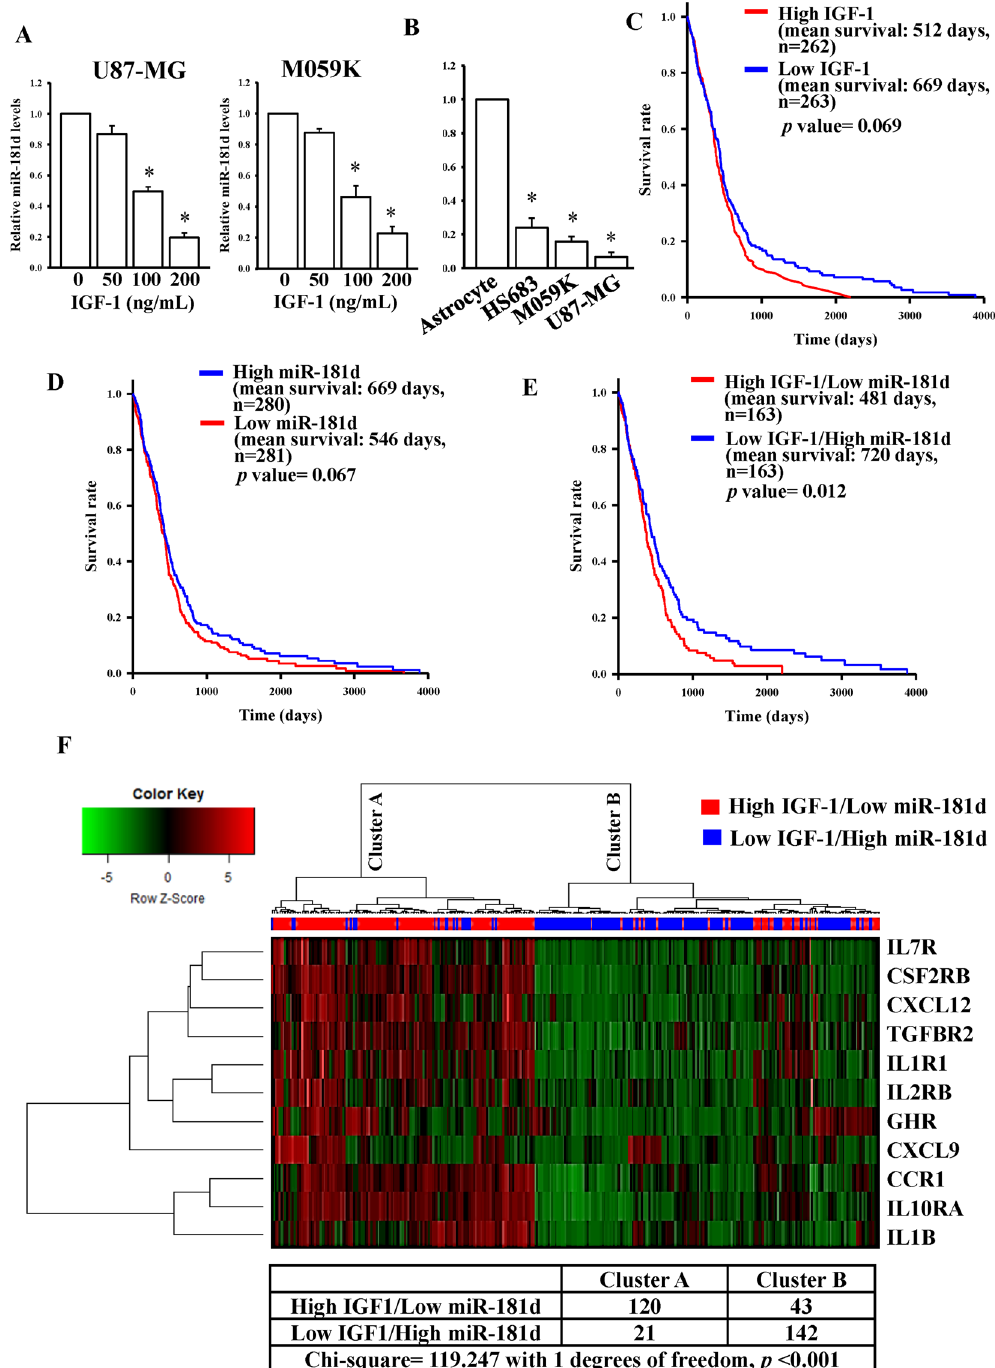
Figure 4. Insulin-like growth factor (IGF)-1/miR-181d status stratifies patient survival. ( A ) Dose-dependent effects of IGF-1 on miR-181d expression levels. ( B ) Detection of endogenous miR-181d levels in normal human astrocytes and three different glioma cell lines, including HS683, M059K, and U87-MG cells. After cells were treated with the indicated doses of IGF-1 for 48 h, RNA was extracted to detect miR-181d levels. Relative expression levels of miR-181d were measured with a real-time PCR. The miR-191-5p level was used as an internal control. Data are the mean ± SD of three experiments. The analyses of Kaplan-Meier survival curves in the IGF-1 ( C ), miR-181d ( D ), and IGF-1 combined with miR-181d ( E ) groups. TCGA glioblastoma multiforme (GBM) patients were divided into two groups based on the median expression cutoff points of IGF-1 and miR- 181d levels. The survival rate was measured by a log-rank test. ( F ) Unsupervised hierarchical clustering of IGF1- miR-181d axis-regulated cytokine